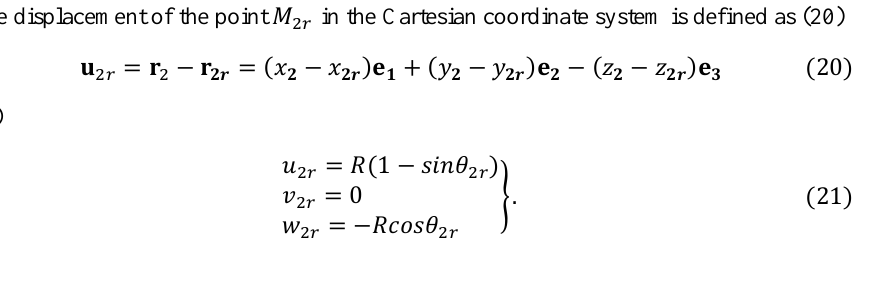
Fig. 27. The mesh fabric pulling: a) direction of mesh fabric main nodes moving, b) mesh fabric actual